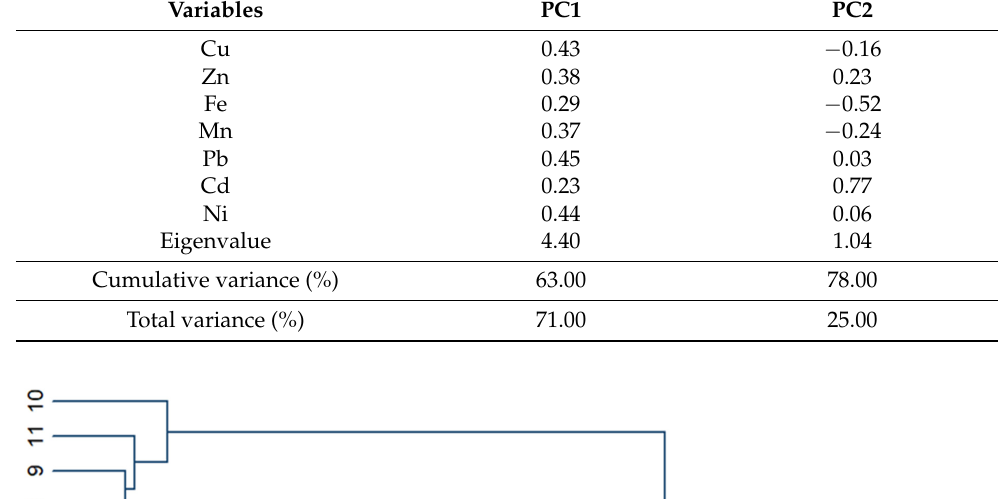
Figure 8. Scree plot of PCA. Table 7. Principal Component Analysis.